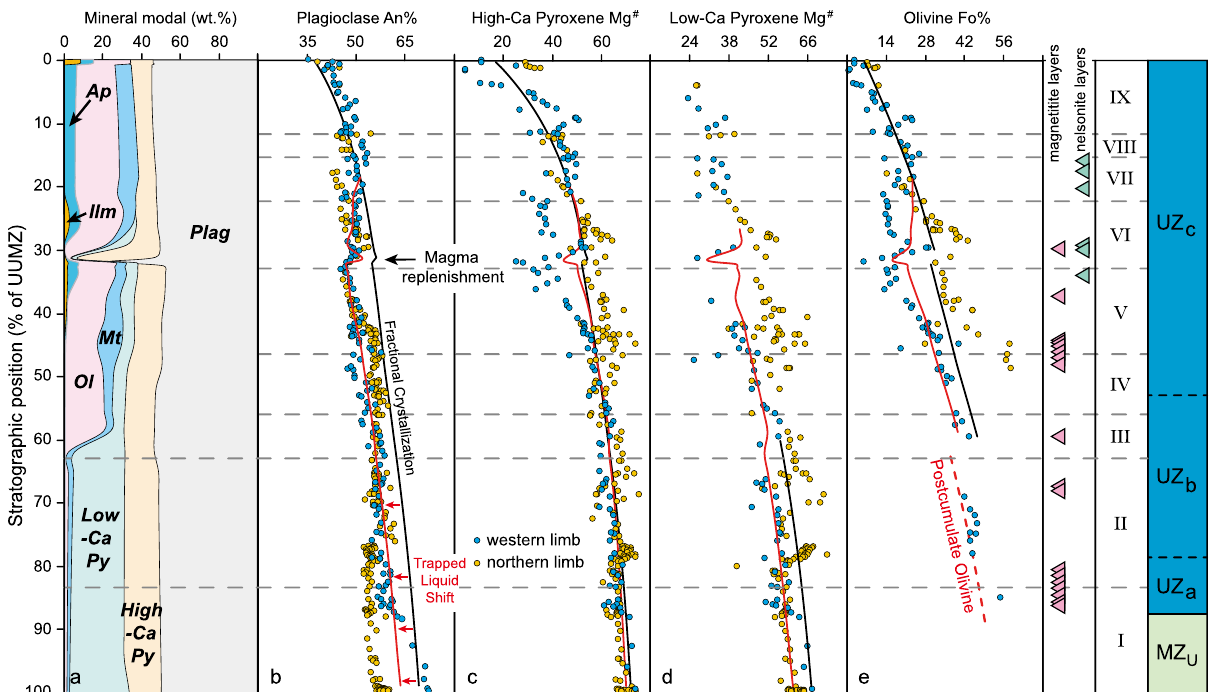
Fig. 5 Modal abundances and compositional variations of minerals throughout the Upper and Upper Main Zone. a The predicted mineral modes from AlphaMELTS modeling for the proposed parental magma of Upper and Upper Main Zone in Fig. 3. Comparisons between the measured composition variations (blue circles from the Bierkraal at the Western Limb 28,31 ; yellow circles from the Bellevue at the Northern Limb 30 ) and model results of b plagioclase (An%, 100Ca/(Ca + Na)), c high-Ca pyroxene (Mg # , 100 Mg/(Mg + Fe)), d low-Ca pyroxene (Mg # ) and e olivine (Fo%, 100 Mg/(Mg + Fe)) with stratigraphic position. Cycles I – VI are identi fi ed by marked reversal in An% number of plagioclase from the Bierkraal drill cores, western limb 28 . A further three cycles (VII – IX) are de fi ned by the disappearance of apatite without apparent reversal in An%, but have still been explained in the same way as cycles I – VI 28 . The Upper Zone contains ~30 magnetitite and nelsonite (magnetite – ilmenite – apatite cumulate) layers that hosts world-class V, Ti, and P sources. Compositional variations of major minerals crystallized from the incoming parental magma are shown as the black lines, and meanwhile the trapped liquid shifts (red lines) represent compositional modi fi cations of minerals induced by the reduction of trapped interstitial melt fraction from 25 to 5% in the post-cumulate stage. Olivine in cycle II is crystallized from the intercumulus melt in this stage, corresponding to its low modal proportion (~1 – 2%) and prismatic shape 31 . Replenishment by ~1.2% initial parental magma at the boundary of cycles V and VI drives apparent reversals of